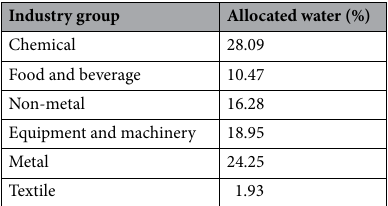
Table 2. Water allocations for the basic scenario.